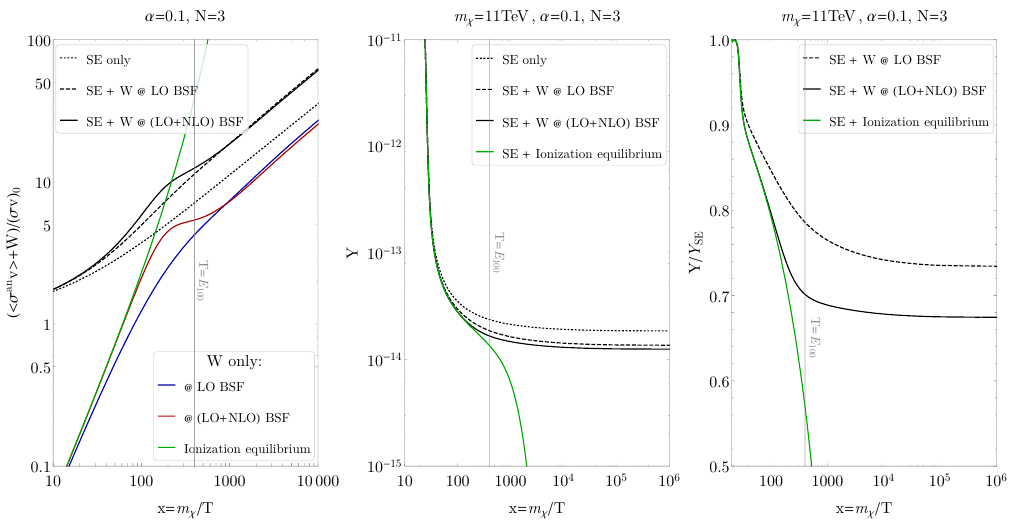
Figure 8 . Impact of bound-state formation at NLO on the evolution of the thermal relic abundance. Here, Y (cid:17) n (cid:31) =s , where s is the SM entropy density, and Y SE assumes Sommerfeld enhanced annihilation